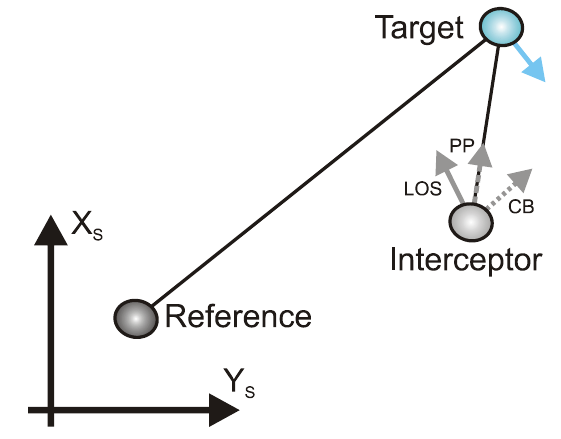
Figure 3: The interceptor velocity commands associ- ated with the classical guidance principles line of sight (LOS), pure pursuit (PP), and constant bearing